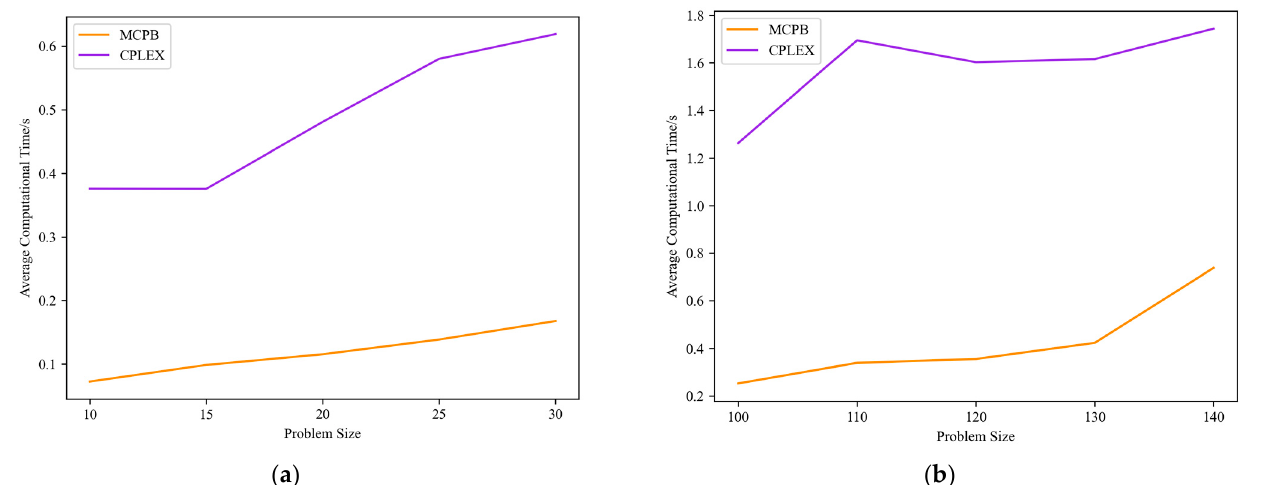
Figure 2. The comparisons of average computational time for MCPB and CPLEX: ( a ) problem size ranging from 10 to 30; and ( b ) problem size ranging from 100 to 140.